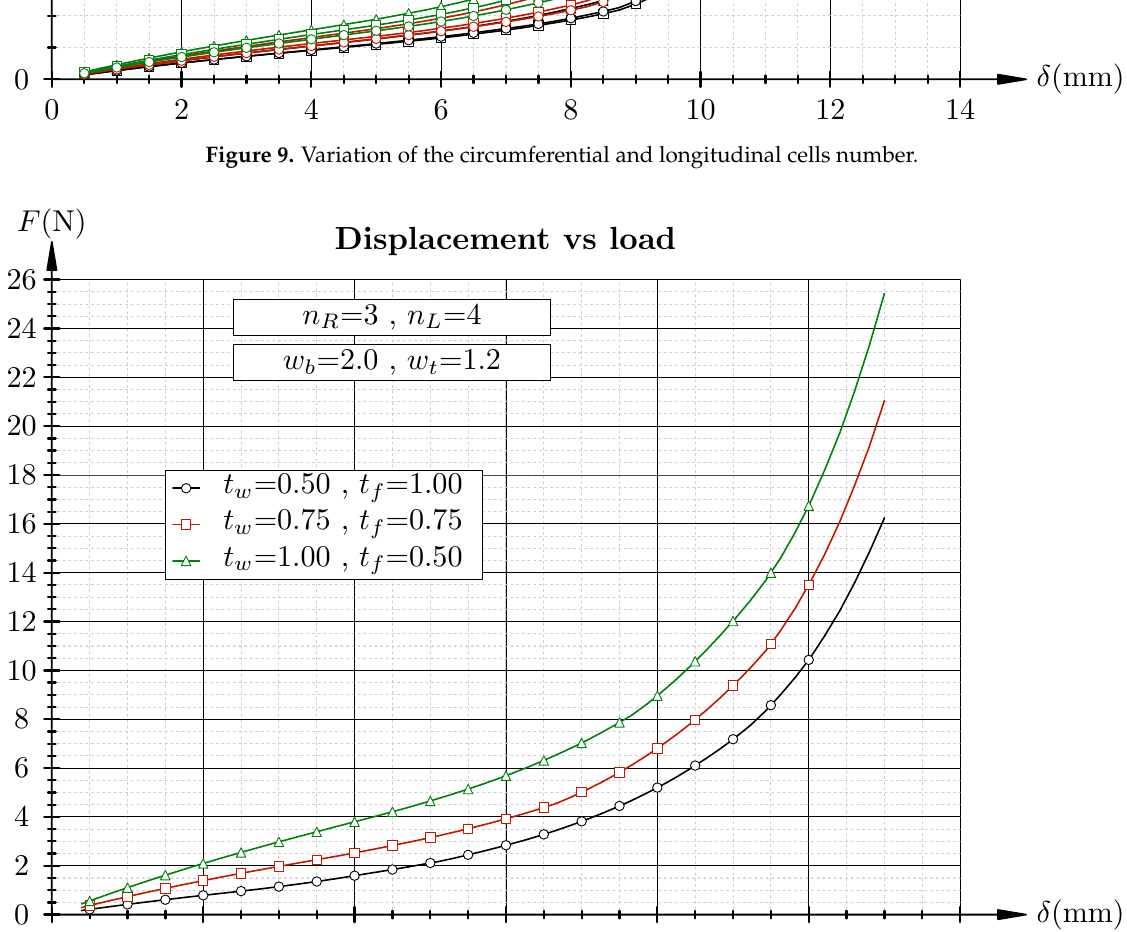
Figure 10. Variation of the thickness distribution within the prosthesis. In Figure 11, the variation of the fiber shape is studied varying the bottom width w b and the bottom and top width ratio w t / w b . The figure clearly highlights that an